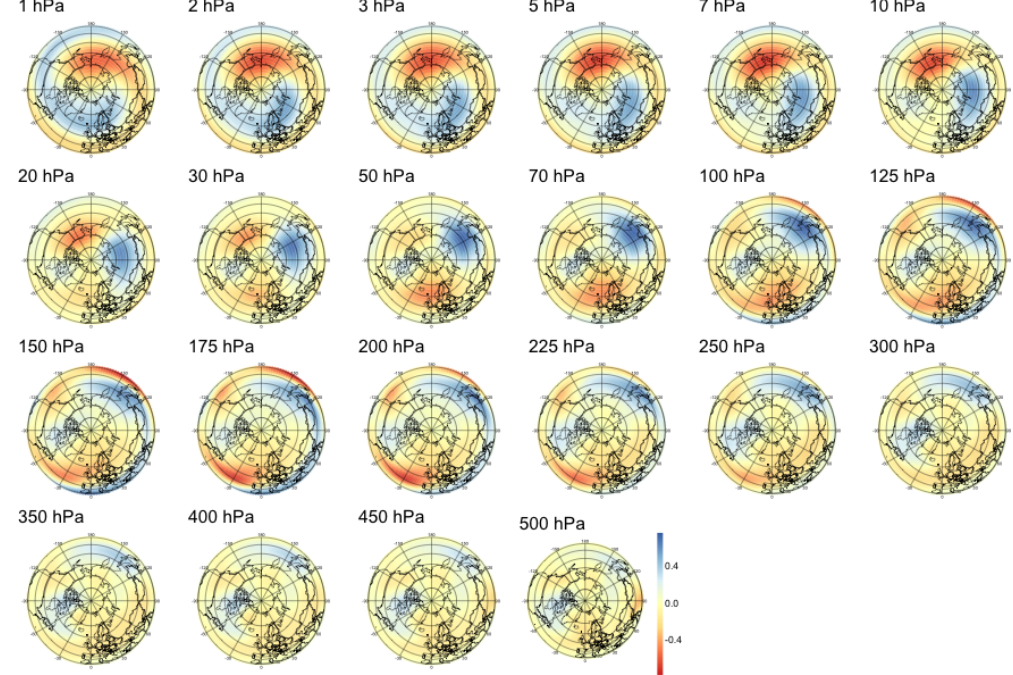
Figure B10. Pattern of PV waves maximizing correlation with the SSW index at a lead time of 60d.